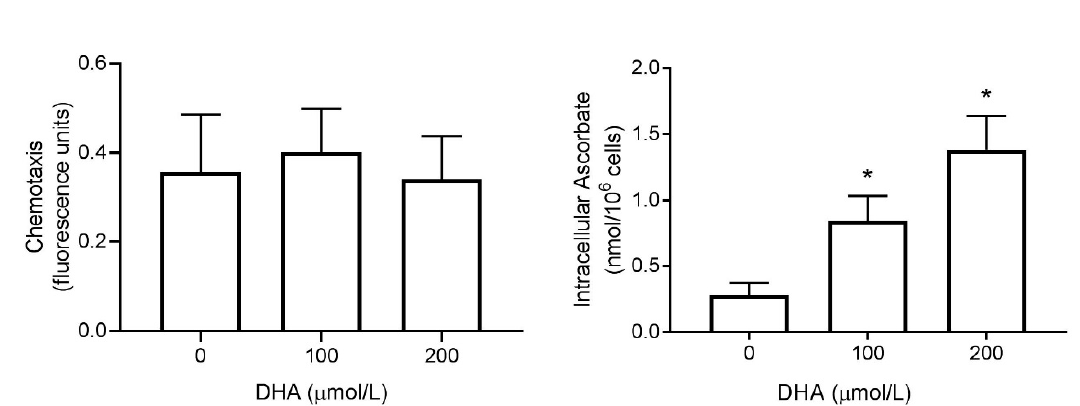
Figure 2. The effect of ascorbate uptake on neutrophil chemotaxis. ( A ) The directional motility of preloaded cells towards a microbial chemoattractant (fMLP). Graphical representation of the fluorescence detected in the lower assay compartment after 30 min. ( B ) The intracellular ascorbate concentration of the preloaded cells was measured using HPLC. Data represent mean ± SEM, n = 3, * p < 0.05.